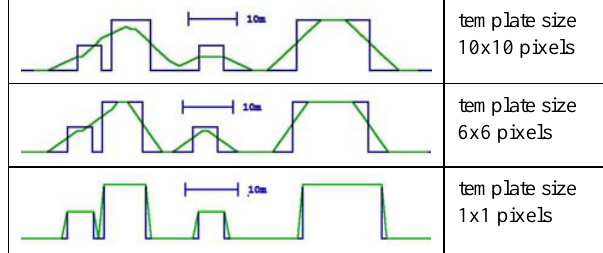
Figure 8: simulated height profiles according to area based matching with 1m GSD (green = inclined lines = generated by area based matching)